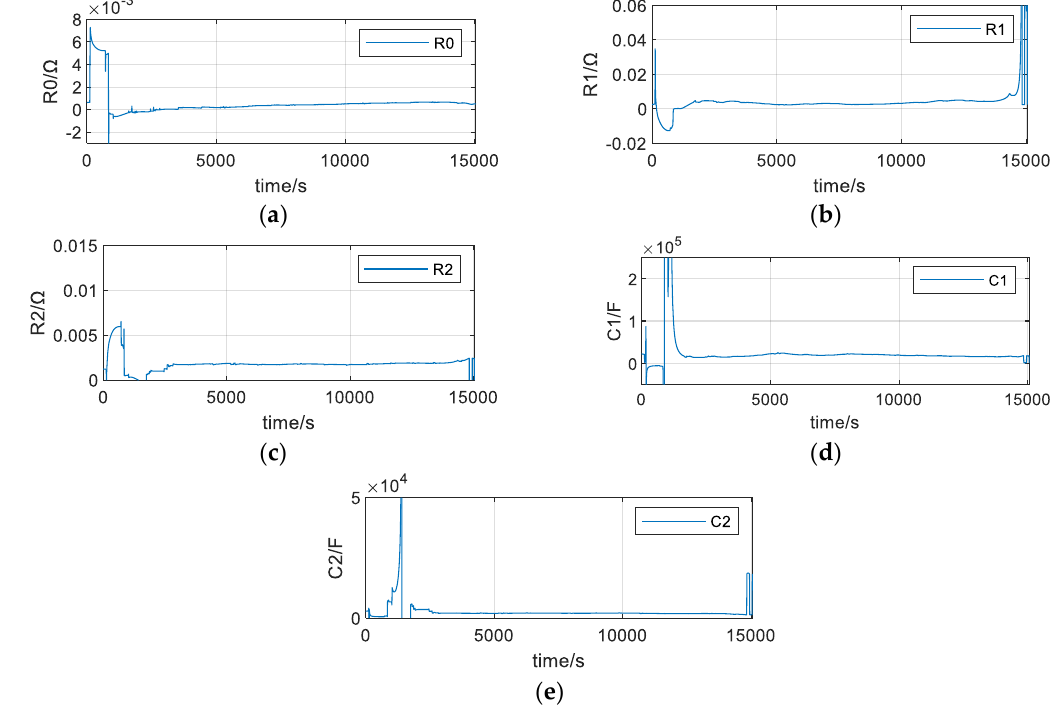
Figure 8. Parameter identification results of the forgetting factor recursive least square (FFRLS) algorithm: ( a ) Identification curve of R 0 ; ( b ) Identification curve of R 1 ; ( c ) Identification curve of R 2 ; ( d ) Identification curve of C 1 ; ( e ) Identification curve of C 2 .